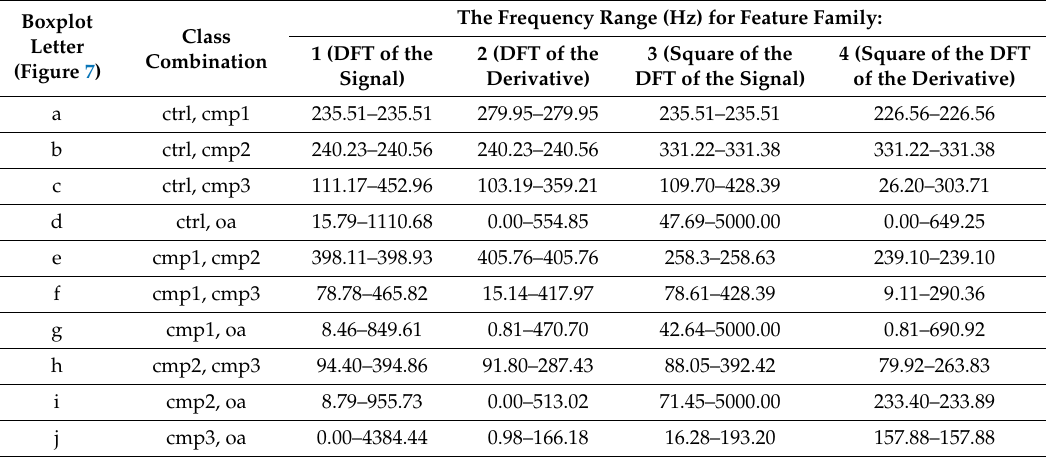
Table 2. Research results: the best frequency range for each feature family, for each class combination. Corresponding Bhattacharyya coe ffi cient values are presented in Table